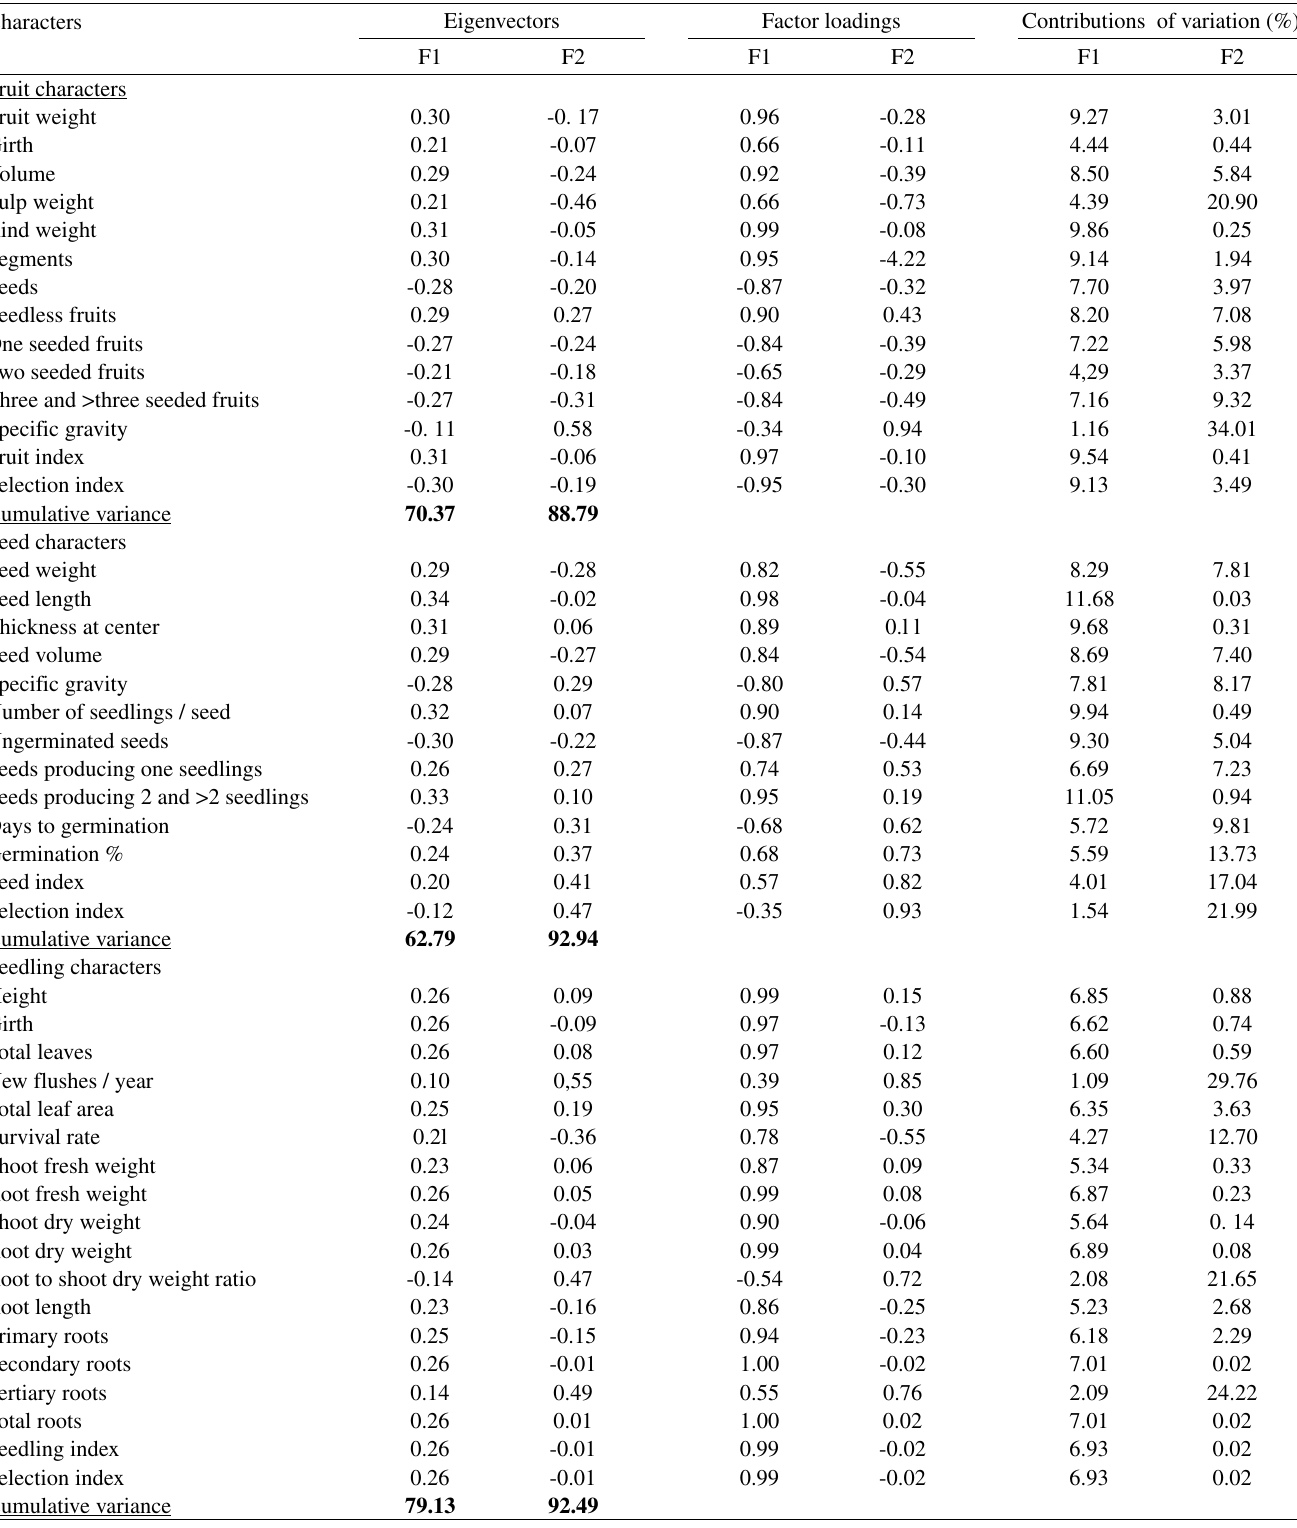
Table 3 - Eigen vectors, factors loadings and contribution of variations by each character in fruit, seed and seedling characters in mangosteen ( Gar- cinia mangostana